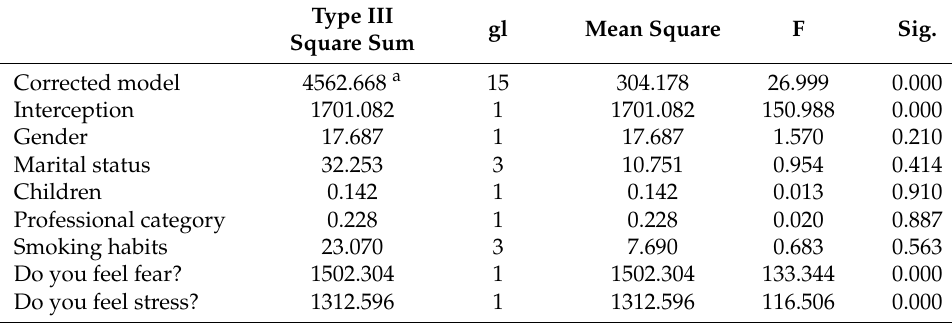
Table 6. Predicting HADS-A